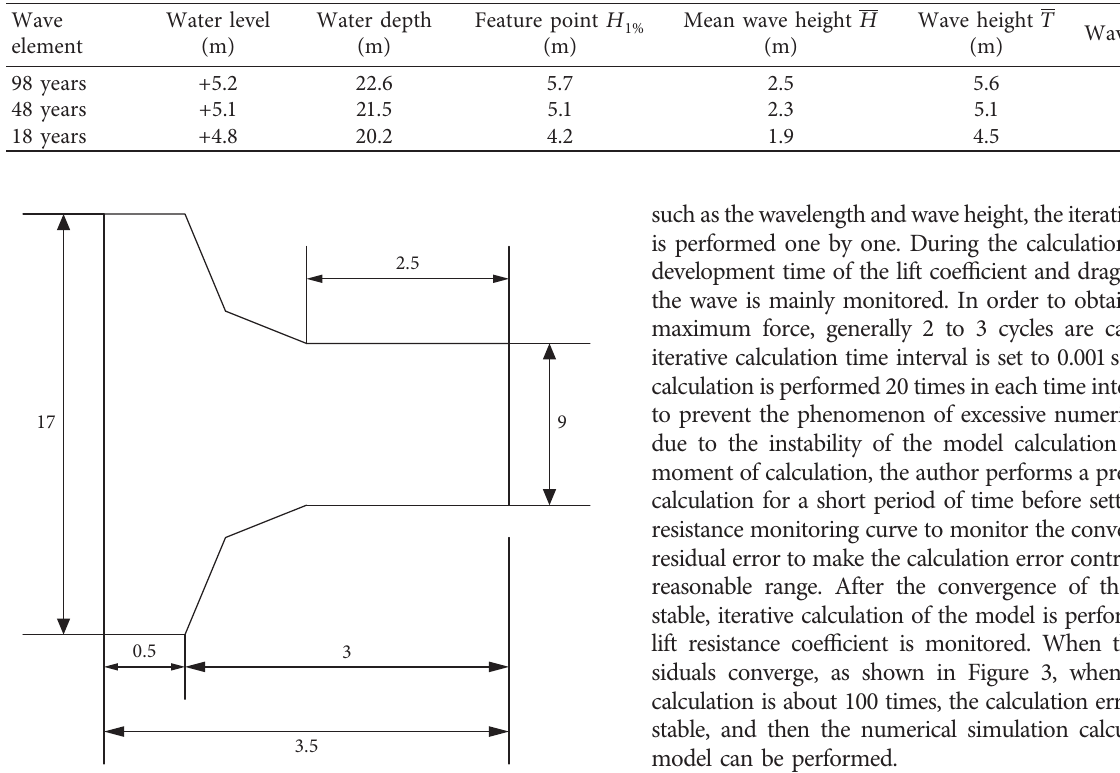
Figure 2: Schematic diagram of bridge cross